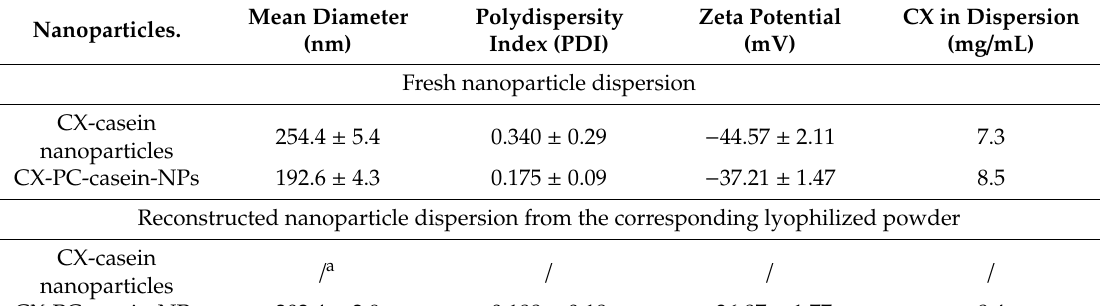
Table 1. Characterization of di ff erent casein-CX nanoparticles.